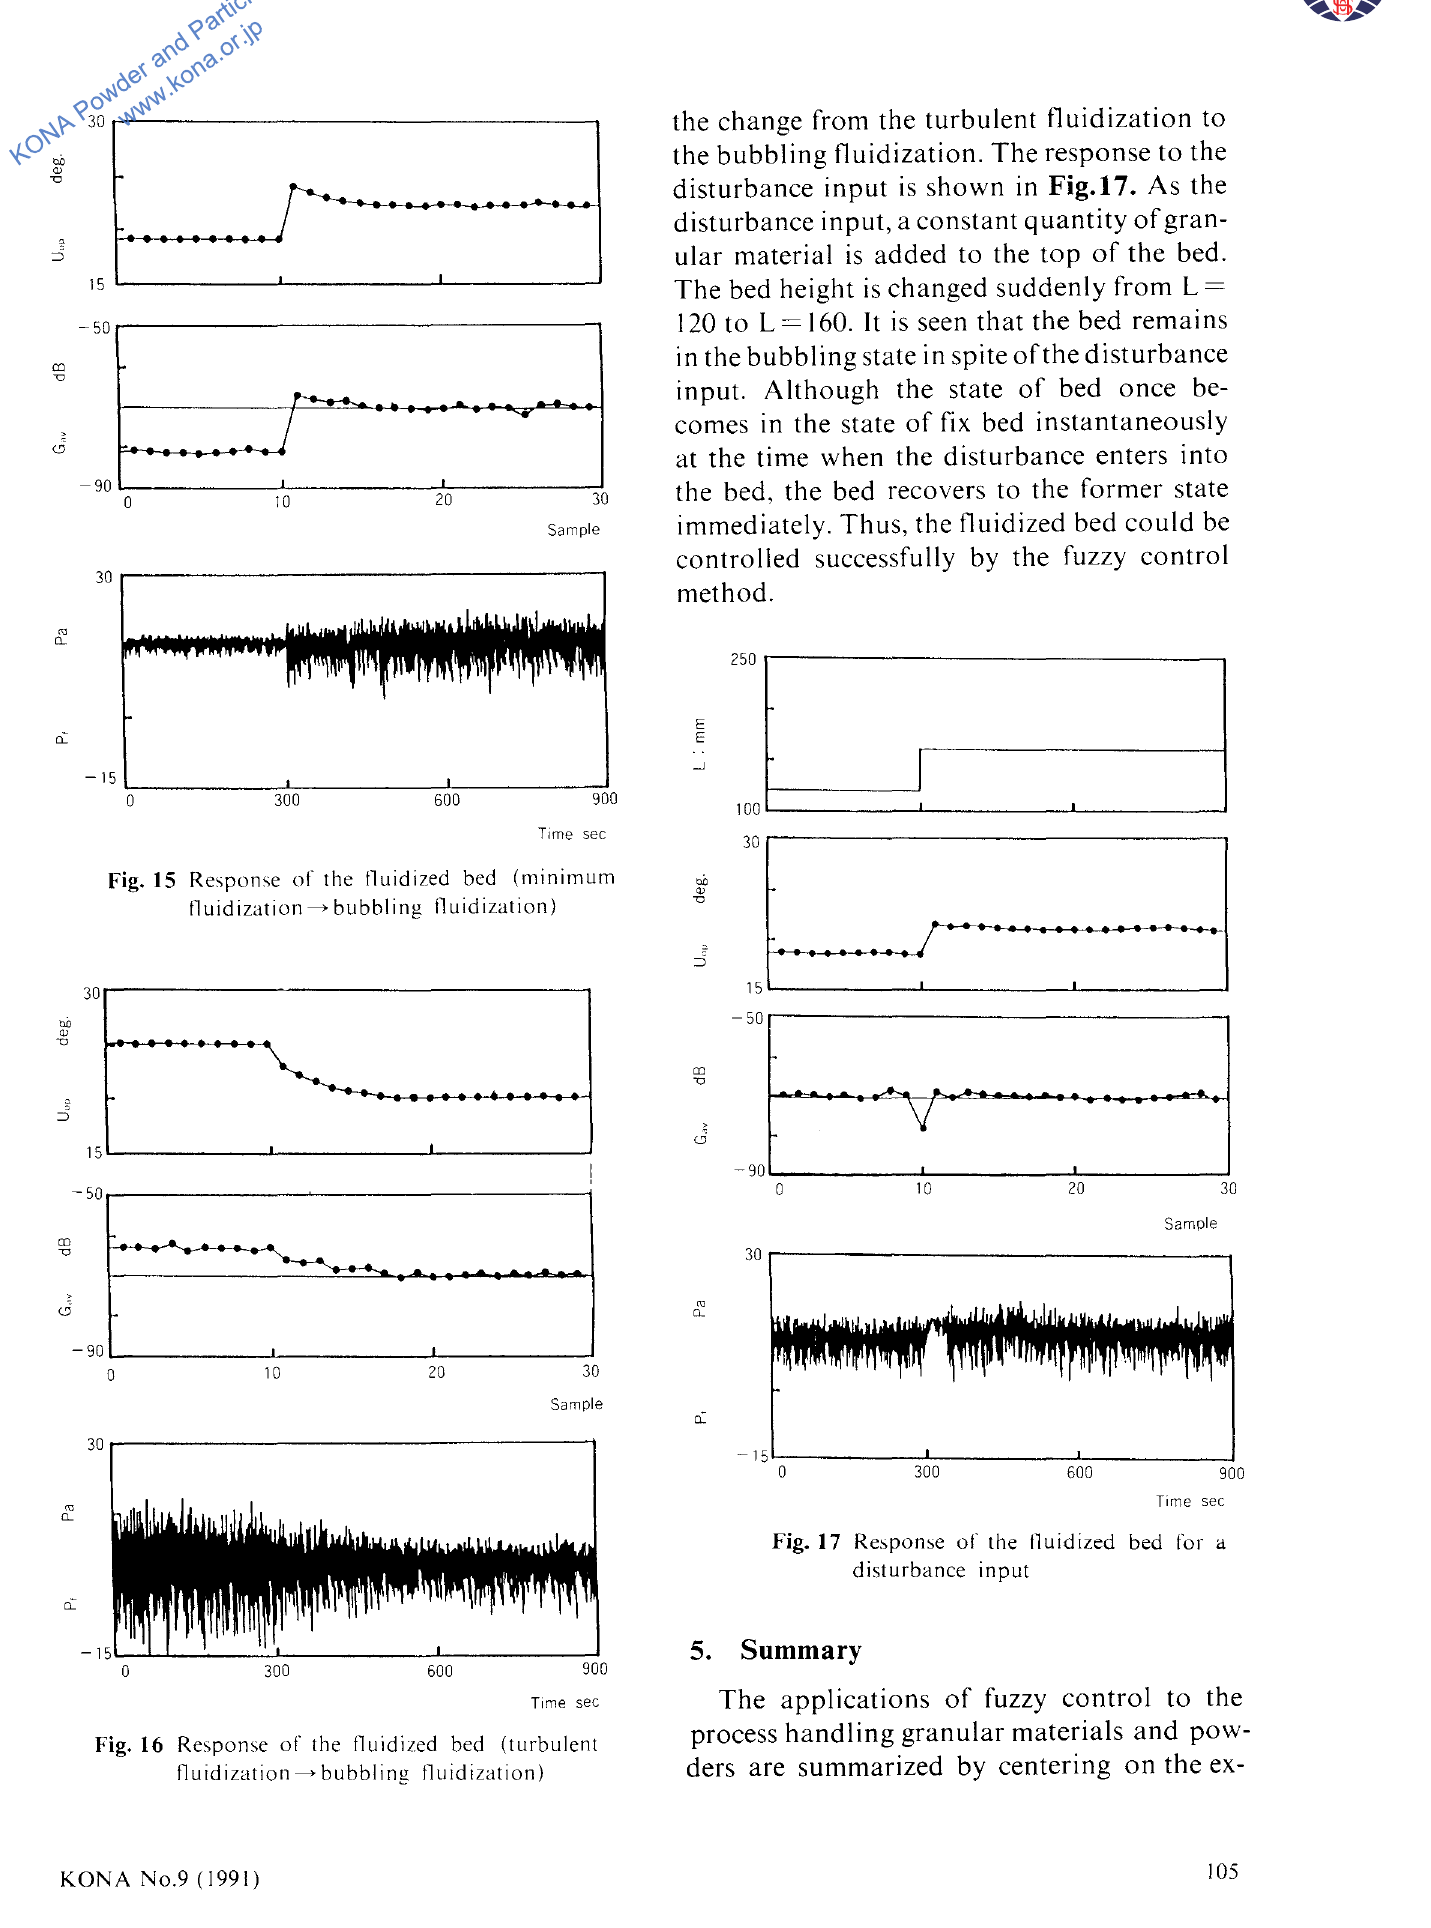
Fig. 16 Response of the fluidized bed (turbulent fluidization---> bubbling fluidization)